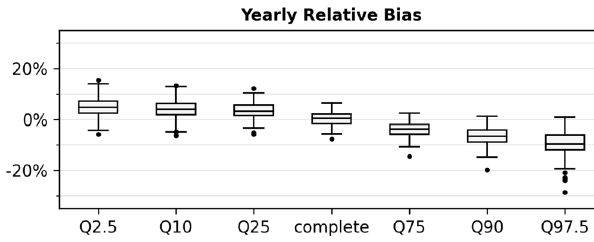
Fig. 5 Model Bias. Evaluation of the yearly, relative model bias on different yearly quantiles at all sites for the 4-year model testing